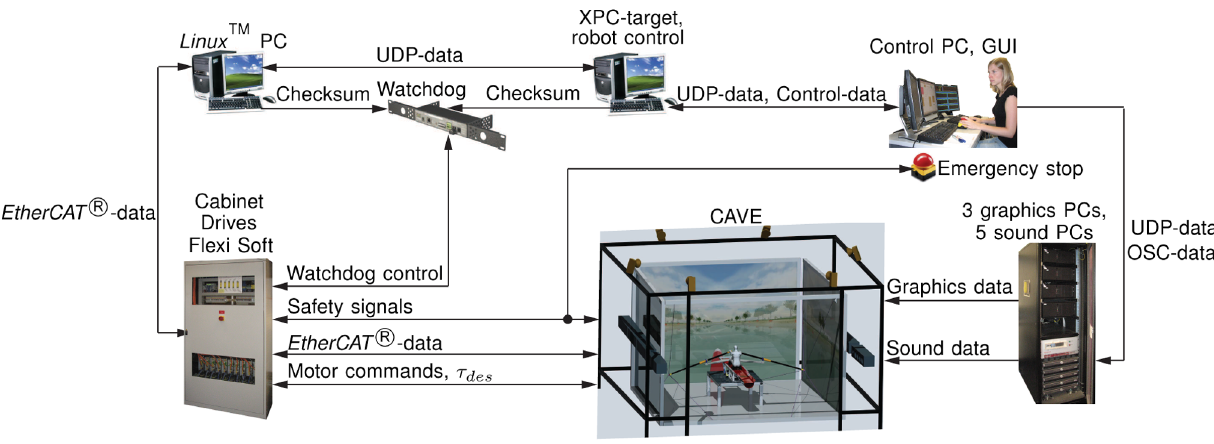
Figure 3. Setup and implementation of data transfer for the scull simulator. One human operator can control the entire scull simulator from the control PC. The core of the setup is the XPC-target that calculates the real-time rowing model and the haptic interaction forces. This XPC- target collects sensor data from the robot and sensors inside the CAVE, processes this data, and transfers it via different protocols to the other PCs that render sound and graphics. Safety of the simulator is constantly guaranteed by a watchdog, safety relays in the cabinet, error detection software in the XPC-target, and the human operator. Furthermore, the participant in the simulator has emergency cords around his wrists that stop the simulator as soon as the hands are too far away from the oar handles.